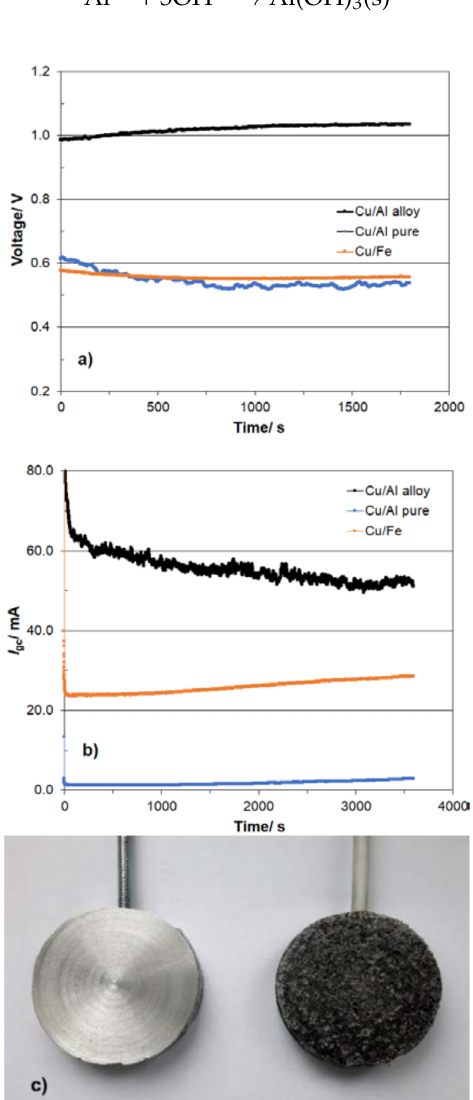
Figure 2. ( a ) Recorded values of open circuit voltage for Cu/Al alloy, Cu/Al pure and Cu/Fe galvanic cells, derived for freshly-prepared, aerated Na 2 SO 4 solution (pH = 7, κ = 5.0 mS cm − 1 , t = 20 ◦ C and 10.5 ppm of dissolved O 2 ). ( b ) Recorded galvanic couple currents for stated cells in function of exposure time (other details as in Figure 2a above). ( c ) Visual condition of sacrificial Al alloy electrode prior to (left) and after (right) the long-time exposure as a galvanic couple with copper